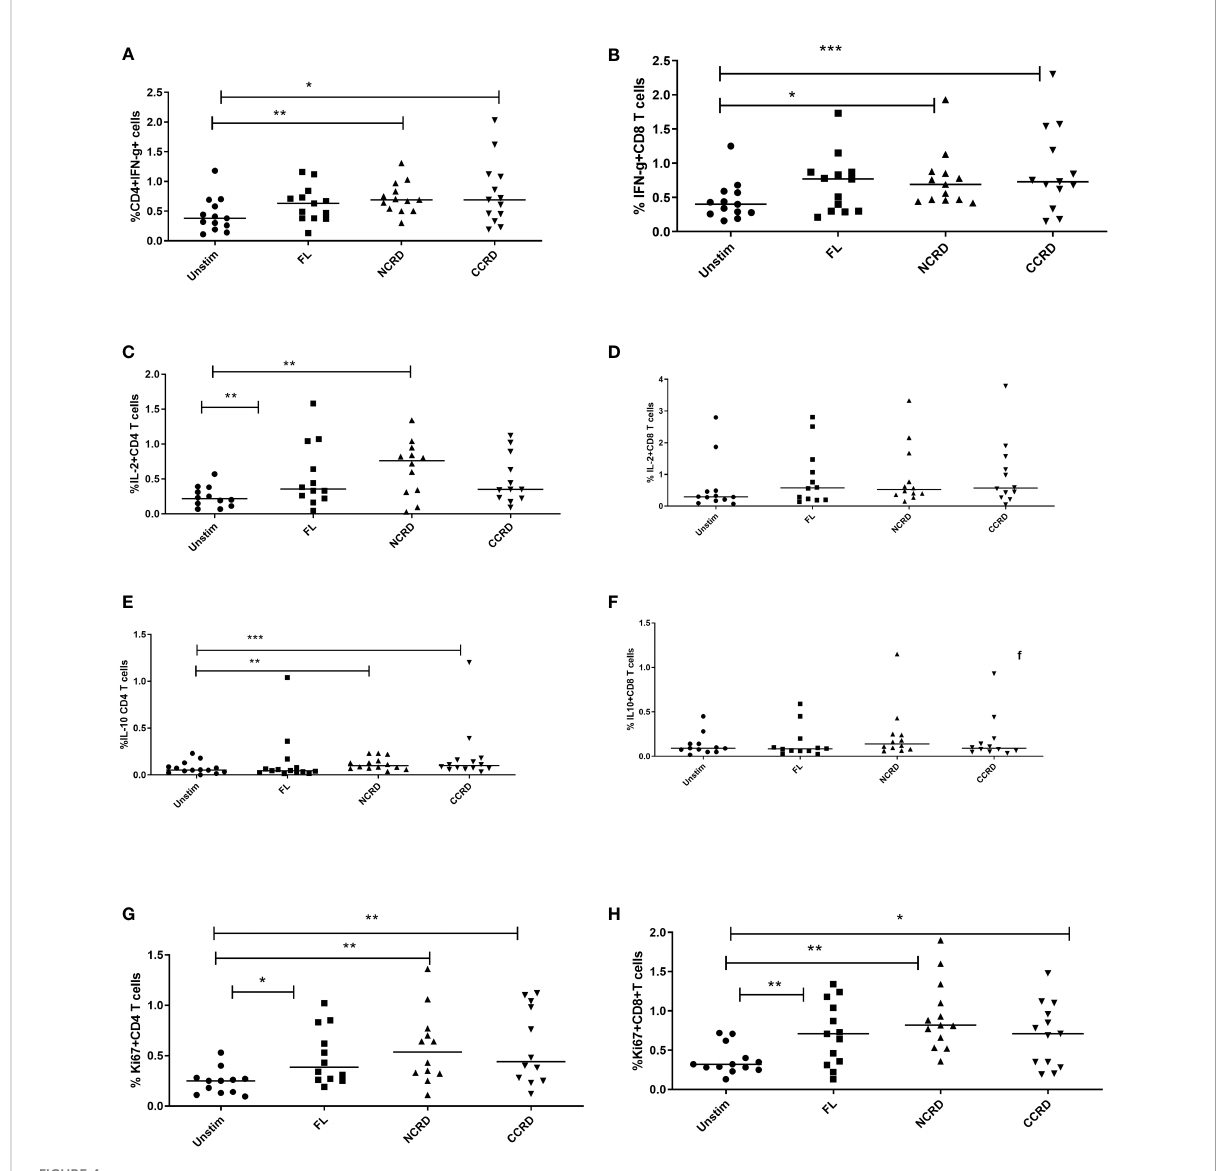
FIGURE 4 Cytokine response after treatment with the full-length and individual Gal-9 CRDs ( n = 11). The cells were acquired on BD FACS Aria Fusion, and data were analyzed by using FlowJo V10 after staining with fl uorochrome-labeled antibodies against IFN- g , IL-2, IL-10, and Ki-67. The % expression of (A) IFN- g in CD4 cells, (B) CD8 cells expressing IFN- g , (C) IL-2 in CD4 cells, (D) IL-2 in CD8 cells, (E) IL-10 in CD4 cells, (F) IL-10 in CD8 cells, (G) Ki-67 in CD4 cells, and (H) Ki-67 in CD8 cells is shown. Individual values are plotted as scatter plots, and the horizontal line represents median values. p -values showing signi fi cant differences ( p < 0.05) between unstimulated and treated cells as calculated by the Wilcoxon signed-rank test are shown. *p < 0.05, **p < 0.01, ***p <